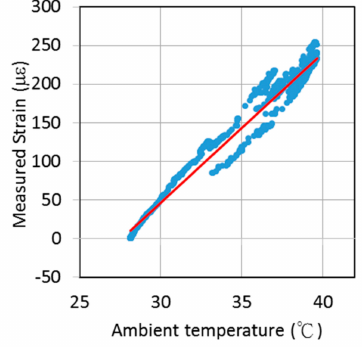
Figure 1. The ambient temperature and measured strain